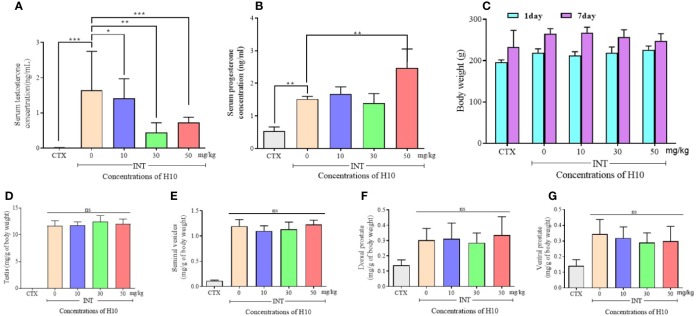
Numerical chart showing the serum levels of (A) T, and (B) P. (C) The levels and body weights, and weights of the (D) testes, (E) seminal vesicles, (F) dorsal prostate, and (G) ventral prostate of SD rats following the i.p. injection of H10 at doses of 0, 10, 30, and 50 mg/kg for 7 consecutive days. Following the i.p. administration of H10 to SD days for 7 consecutive days, the levels of T were significantly suppressed, although the serum levels of P slightly increased following the administration of H10 at a dose of 50 mg/kg. There were no significant differences in the body weights of the SD rats, along with the weights of the testes, seminal vesicle and prostate, seminal vesicle, and testes following H10 treatment in comparison with those of the normal SD rats. However, the index parameter of the castrated SD rats significantly decreased in comparison to those of the INT groups (n = 6, means ± sd, *P < 0.05, **P < 0.01, and ***P < 0.001 are considered significant vs. the INT H10 (0 mg/kg) group, ns indicates no significant difference vs. the INT H10 [0 mg/kg] group, P > 0.05).